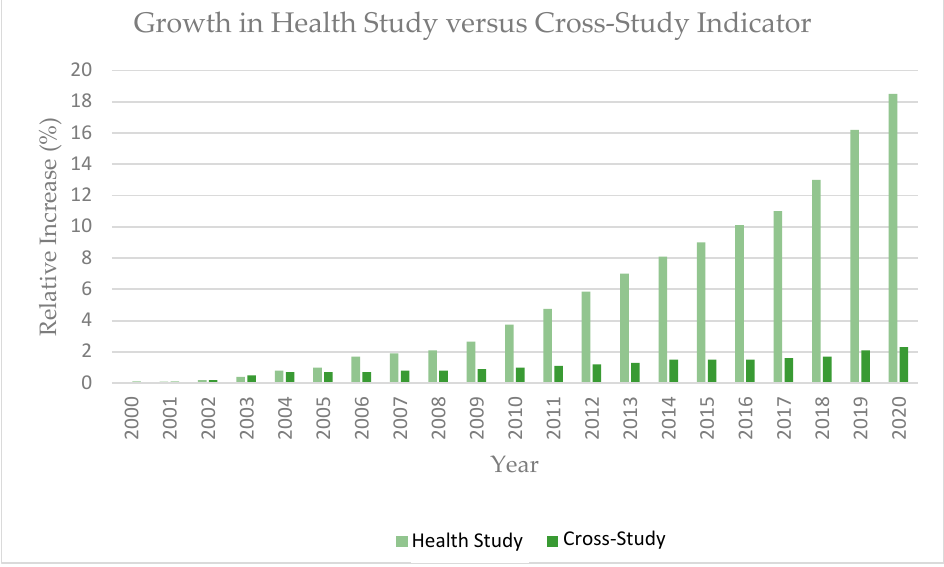
Figure 1. Relative increase in cross-study analyses compared to the relative increase in health study publications indexed in PubMed since 2000 [18] . Cross-study analyses were identified by searching for “meta-analysis”, “meta-analyses”, or “systematic review”.